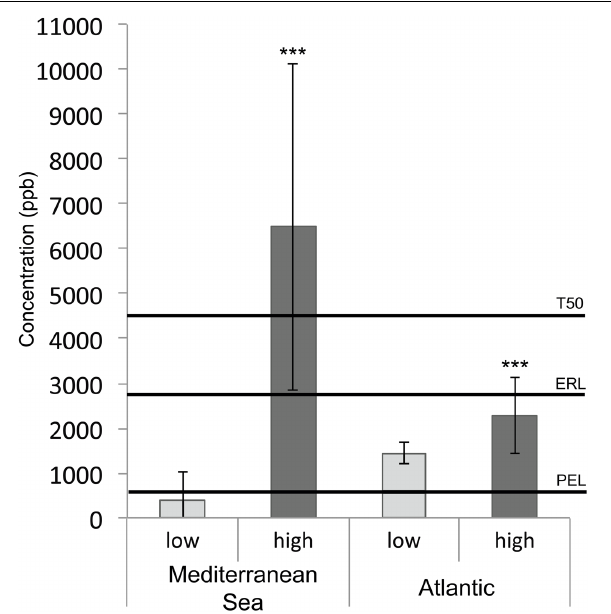
FIGURE 2 | Histogram presenting high and low PAH concentrations ( µ g/kg dw - sum of 9 individual compounds (cid:54) PAH 9 : fluoranthene, pyrene, anthracene, ben[ a ]anthracene, benzo[ ghi ]perylene, chrysene, dibenz[ a,h ]anthracene, fluorene, indeno[1,2,3- cd ]pyrene, phenanthrene) in sediment samples from the Mediterranean Sea and Atlantic coasts. The asterisks indicate significant differences between highly contaminated and non-contaminated samples ( p < 0.001). The plotted thresholds (solid line) correspond to Sediment Quality Guidelines: Probable Effect Level (PEL), Effect Range Low (ERL), and 50% toxicity concentration